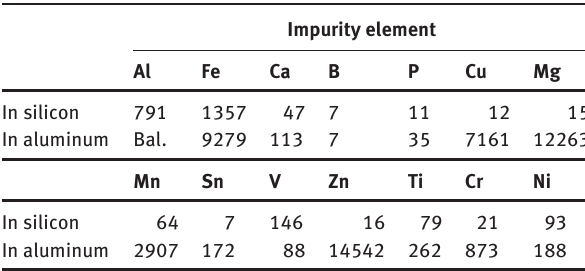
Table 1: Impurity content in raw materials (ppmw) Impurity element